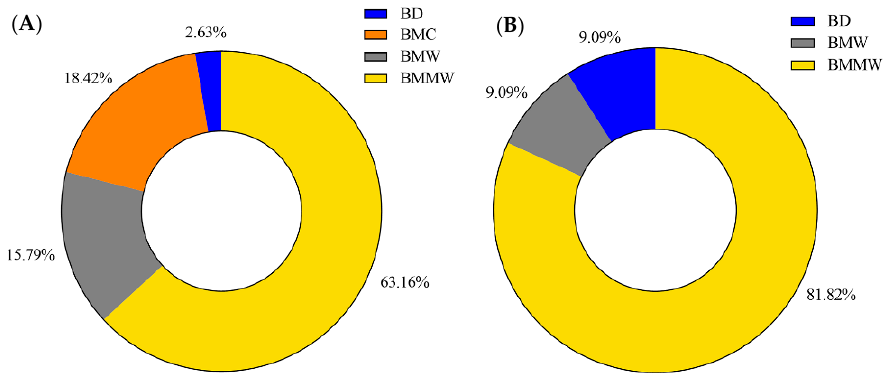
Figure 3. The percentage of the highest extraction recovery each method occupied in ( A ) signaling lipids and ( B ) polar metabolites.